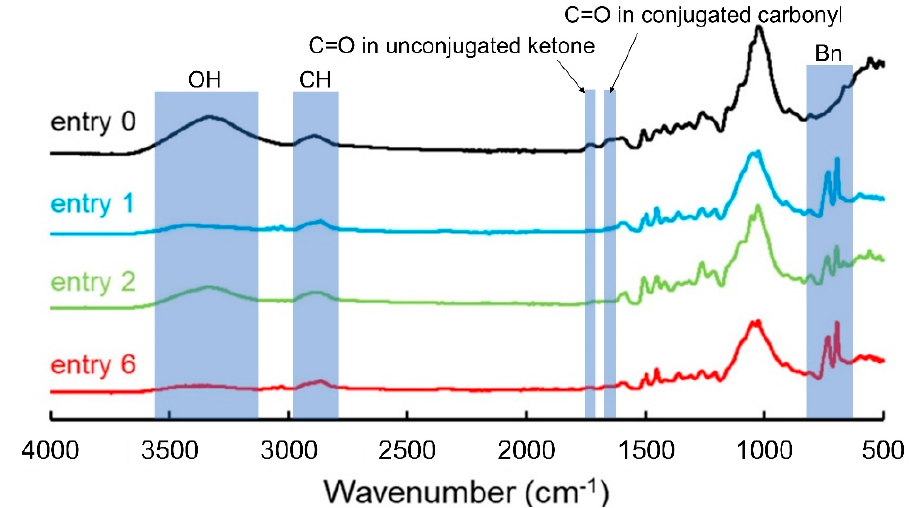
Figure 1. FT-IR spectra of degreased wood (entry 0, black) and benzylated woods (entry 1, blue; entry 2, green; and entry 6, red).